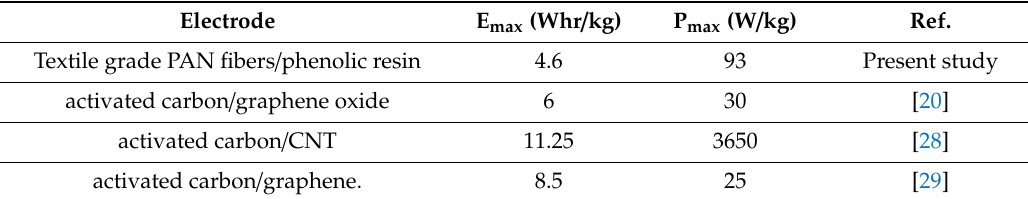
Table 8. E max and P max values of some composite monolith electrodes.